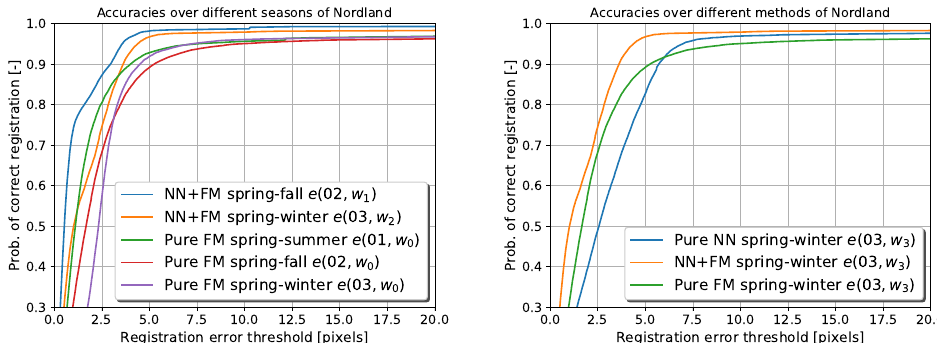
Figure 7. Error rates on the Nordland dataset using the visual teach and repeat with and without learning for each autonomous repeat ( left ). Error rates of the pure neural network output compared to pure feature matching and their combination ( right